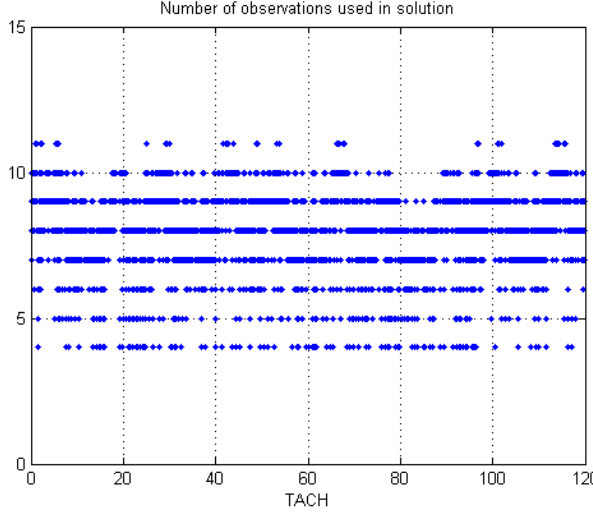
Figure 25. The number of satellites used in positioning in Taipei FIR (3 RSs).